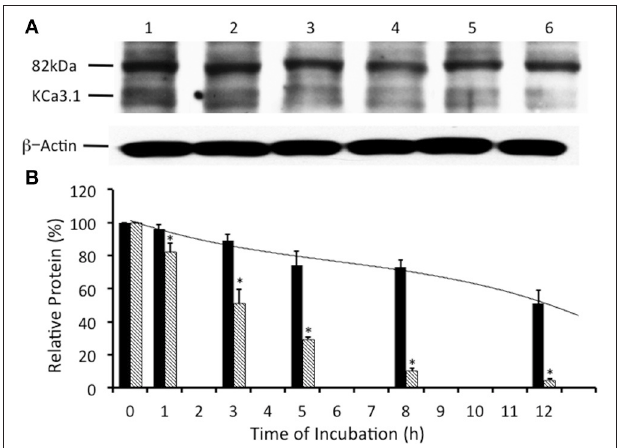
FIGURE 6 | Effect of deubiquitinase inhibition via PR-619 on the streptavidin-labeled membrane bound KCa3.1-BLAP channels. (A) After streptavidin labeling, cells were further incubated in 37 ◦ C for 0 (no incubation), 1, 3, 5, 8, or 12 h with PR-619 (50 µ M) before being lysed and detection of